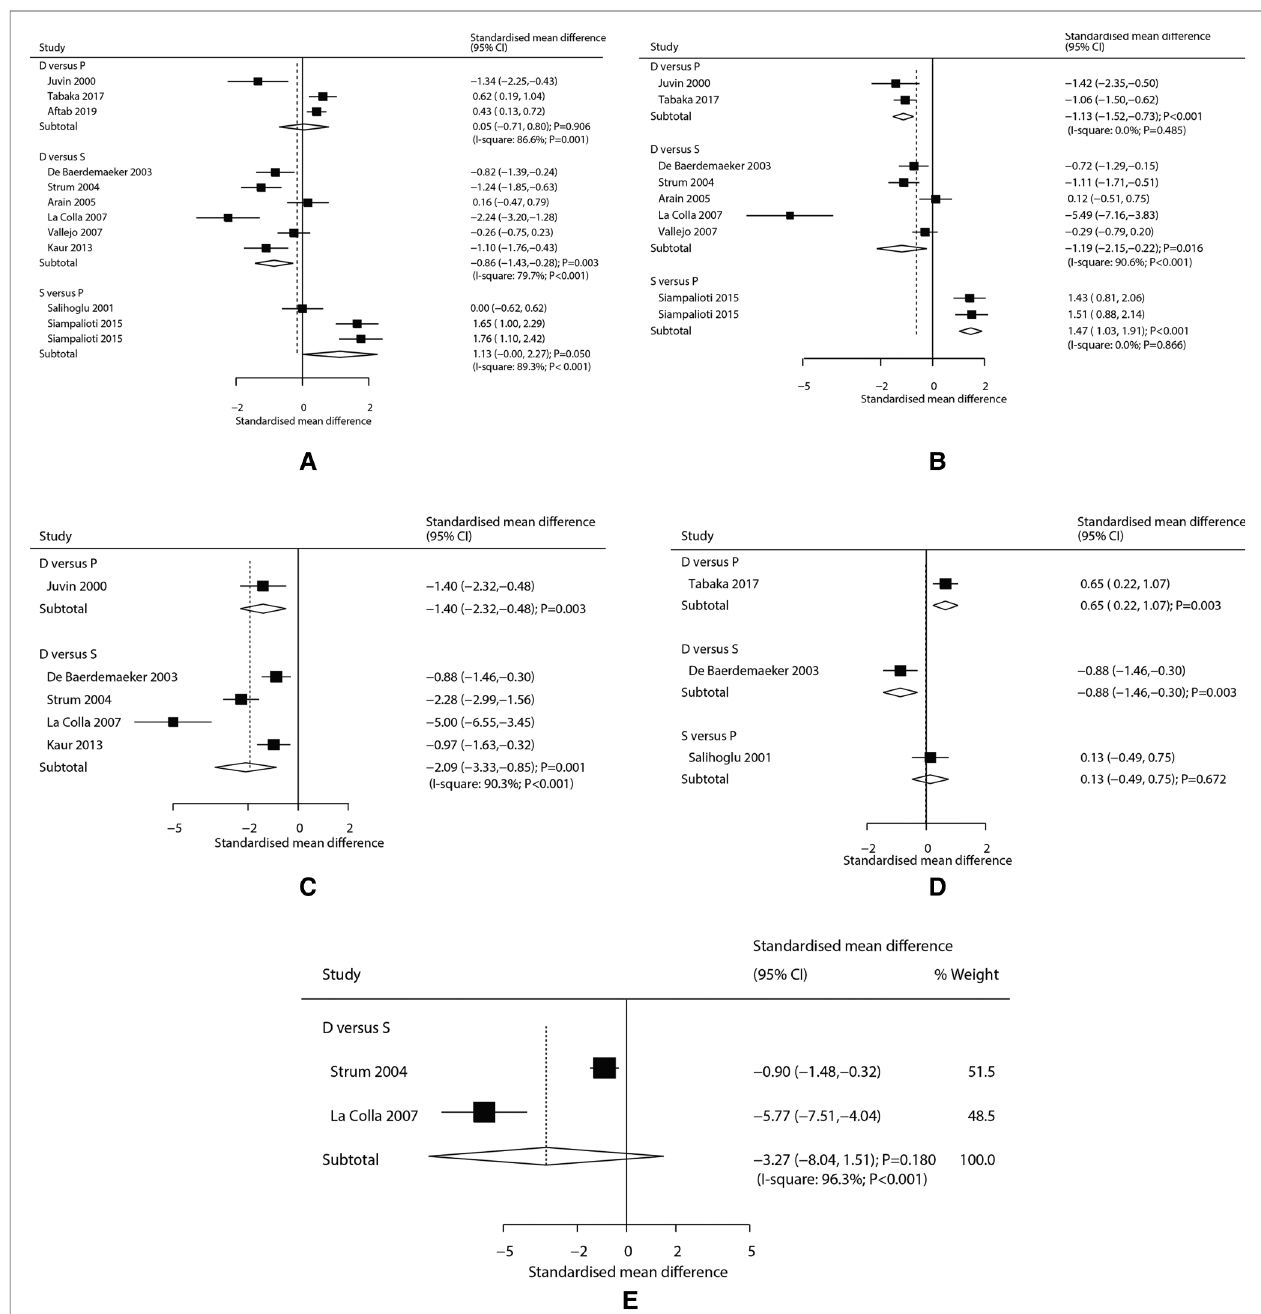
FIGURE 2 | ( A ) Effects of various anesthetics on time to eye opening, ( B ) Effects of varies anesthetics on time to extubation, ( C ) Effects of various anesthetics on time to stating name, ( D ) Effects of various anesthetics on time for orientation to place, ( E ) Effects of varies anesthetics on time required for hand